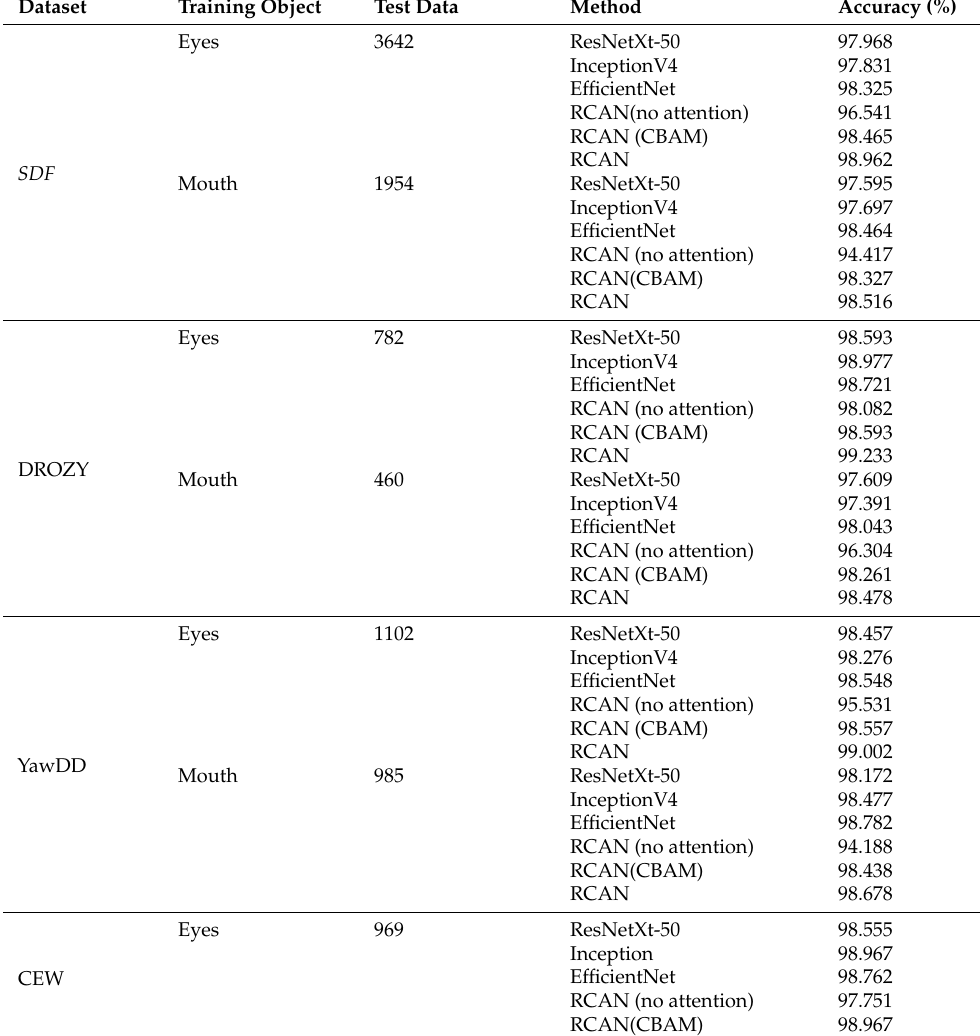
Table 3. Classification accuracy of the RCAN and different classical CNN structures on four